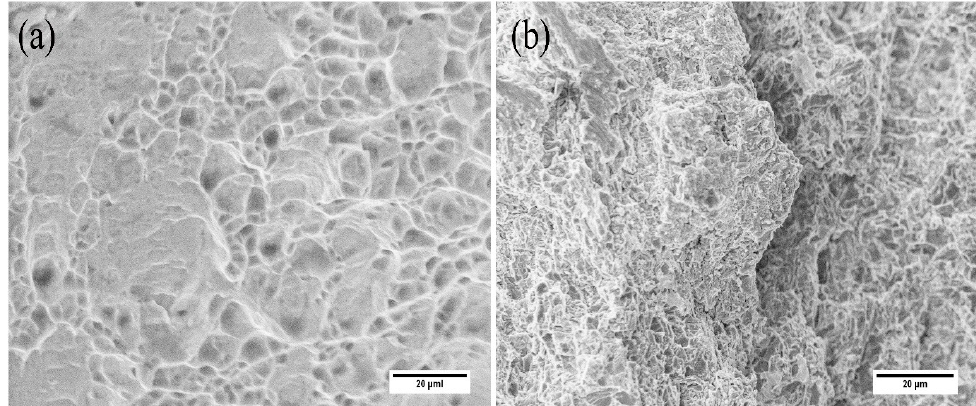
Figure 13. The rapture morphology of composites with ( a ) one and ( b ) eight steps APB process.